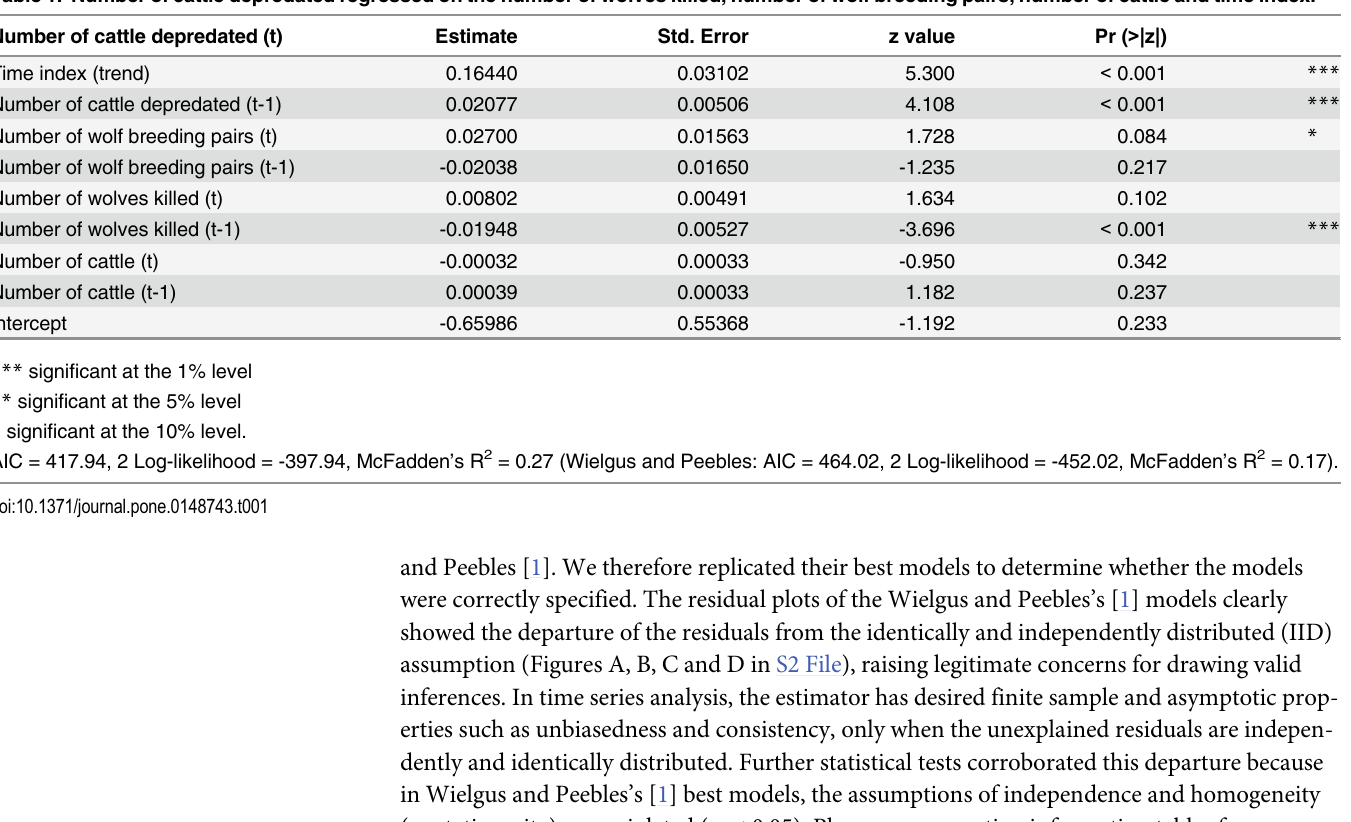
information on misspecification tests (Tables A, B and C in S3 File).